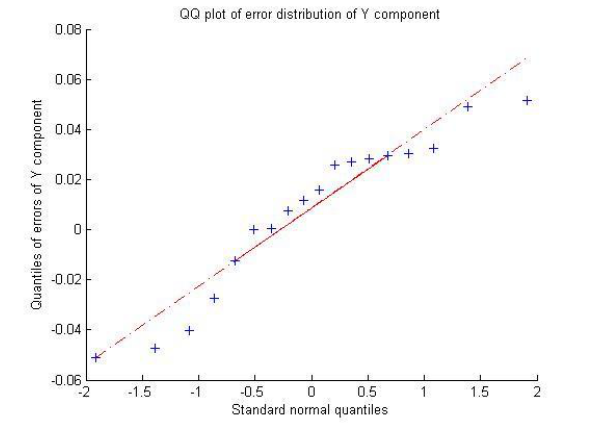
Figure 9. Q-Q plot for the distribution of ΔY Based on this we decided to calculate further the robust accuracy measures (Table 4).